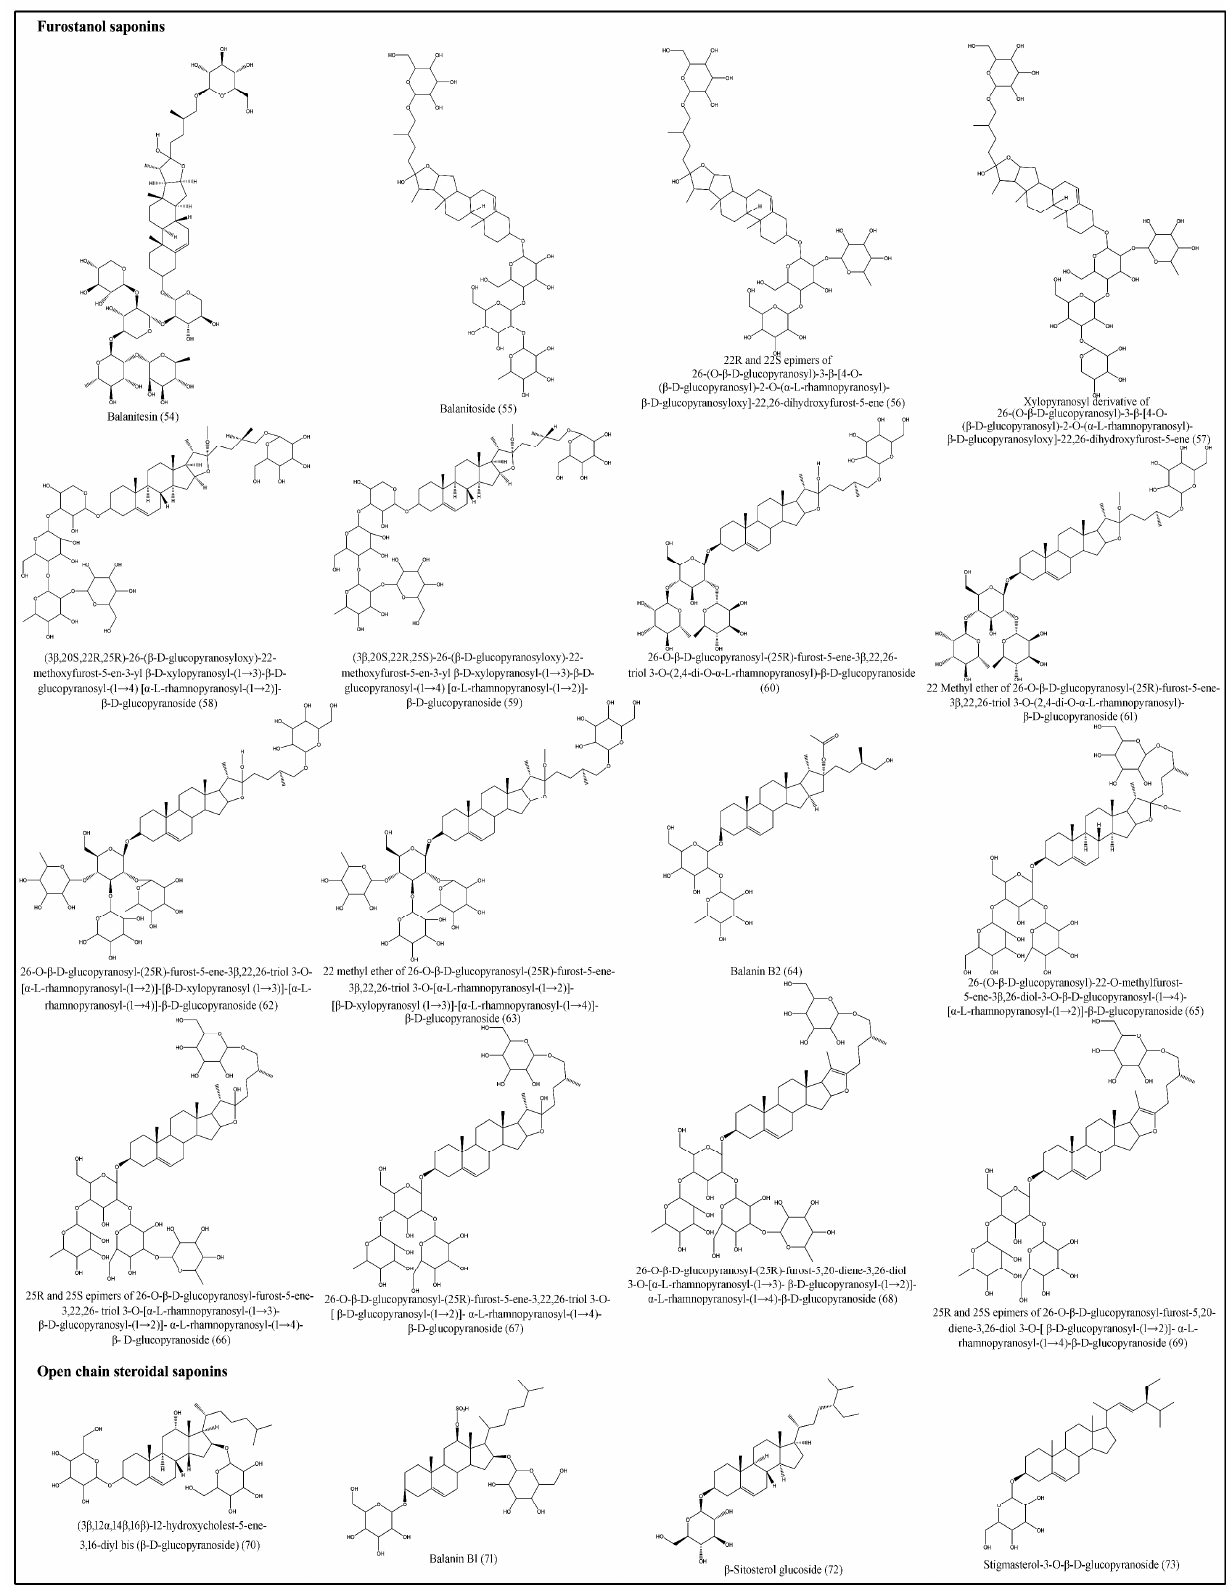
Figure 6. Structures of furostanoland open-chain steroidal saponins of desert